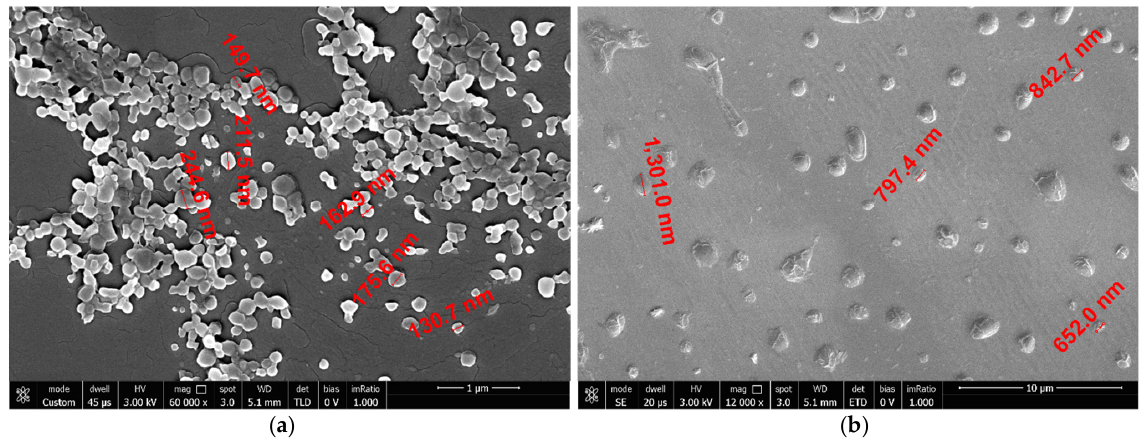
Figure 3. Scanning electron microscopy (SEM) images of EO-loaded NPs. PHB NPs ( a ); PHB-HHx NPs (panel b ). The size of both nanoparticles ( a ) and aggregates ( b ) are indicated in red. The crystalline or amorphous nature of PHB and PHB-HHx nanoparticles was directly probed by performing Wide Angle X-ray measurements (WAXS) on dehydrated aliquots of nanoparticles loaded with EO. As shown by the diffraction profiles reported in Figure 4, the PHB NP sample is highly crystalline, according with the presence of reflections (020), (110), (101) and (111) of PHB α form located at around 2 θ = 13°, 17°, 21.5° and 22.5°, respectively [36].